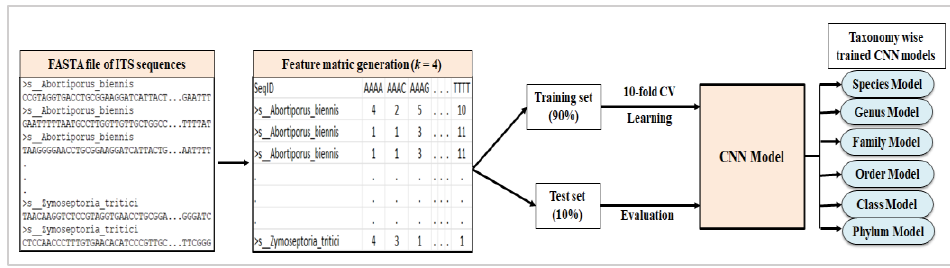
Figure 4. Pipeline for training and evaluation of CNN models starting from feature matrix generation from FASTA file of ITS sequences.